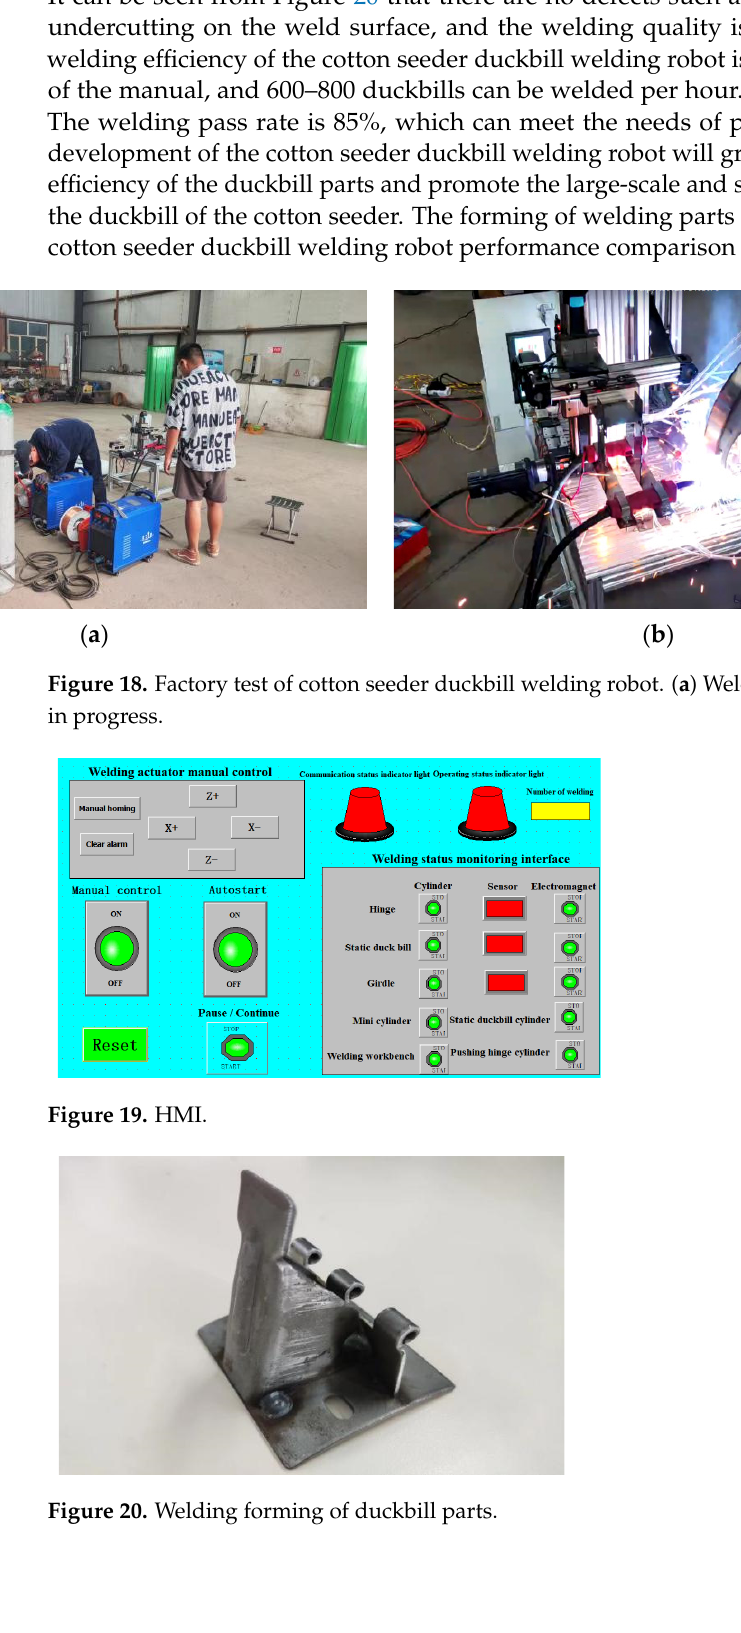
Figure 17. Cotton seeder duckbill welding robot.